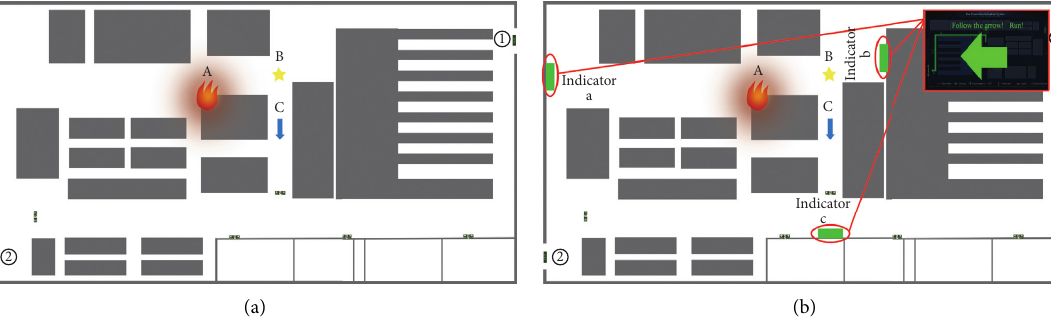
Figure 10: Top view of the experimental scene. Points A, B, and C represent the fire source, starting position, and route of travel, re- spectively. (a) Control group; (b) experimental group.